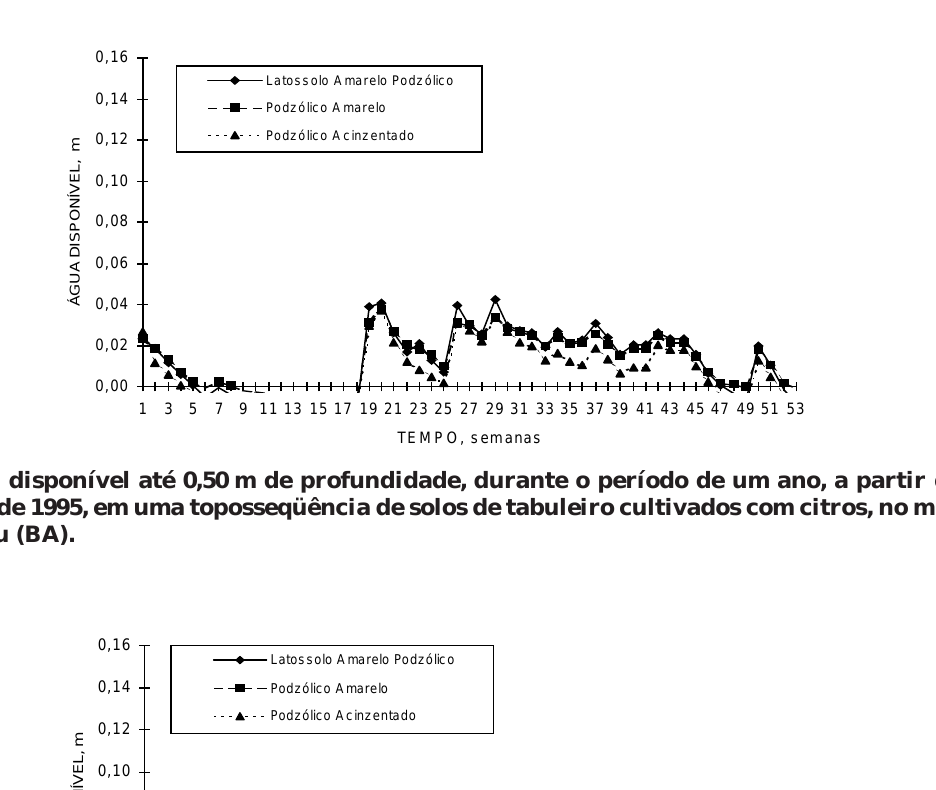
Figura 3. Água disponível até 0,30 m de profundidade, durante o período de um ano, a partir de 18 de dezembro de 1995, em uma toposseqüência de solos de tabuleiro cultivados com citros, no município de Sapeaçu (BA).